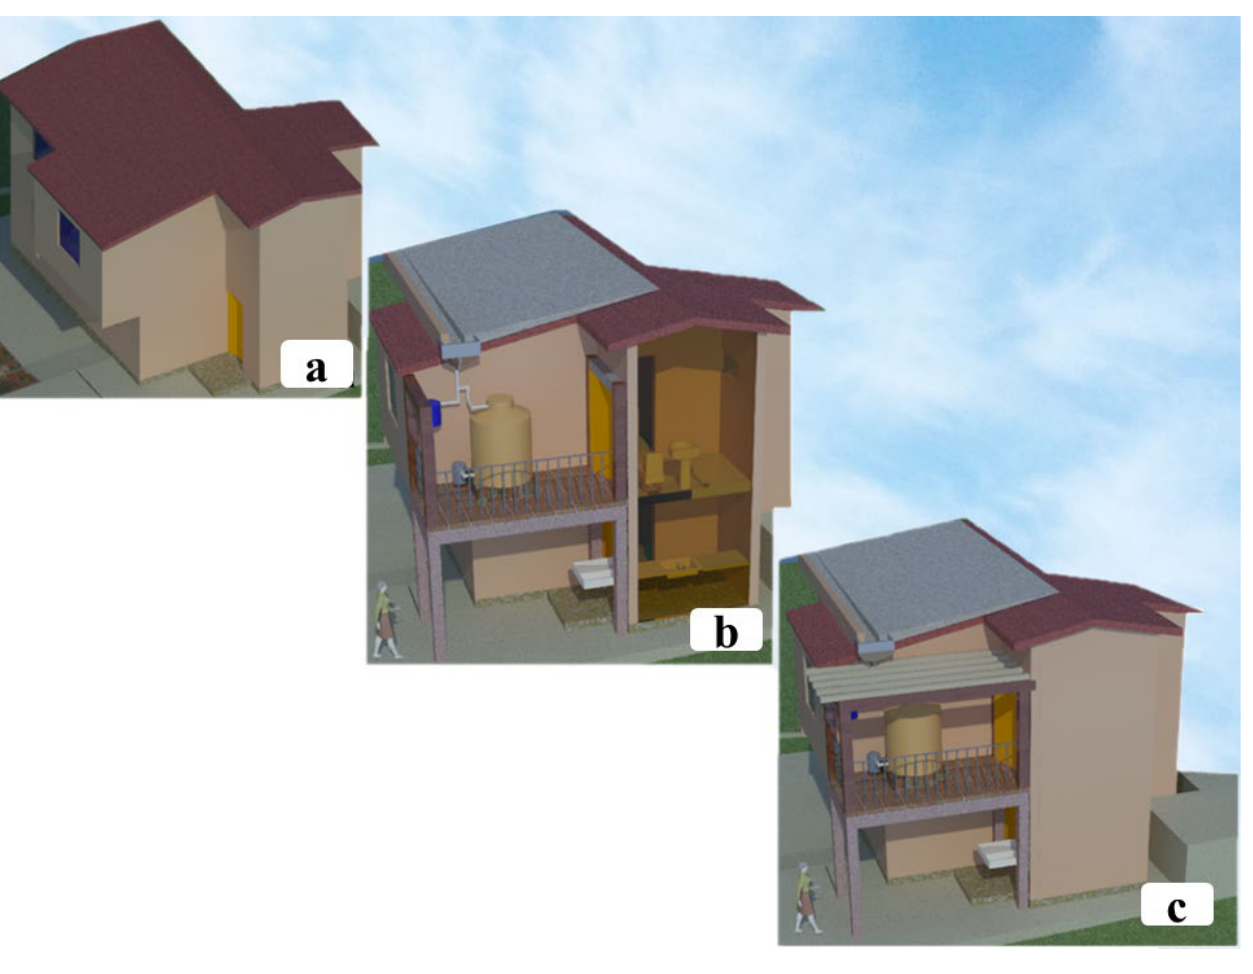
Figure 9. Proposed modifications to the pattern single-family household based on installing the rainwater harvesting system. ( a ) SFH original condition, ( b ) Detail of RWHS installation, ( c ) SFH final volumetry.